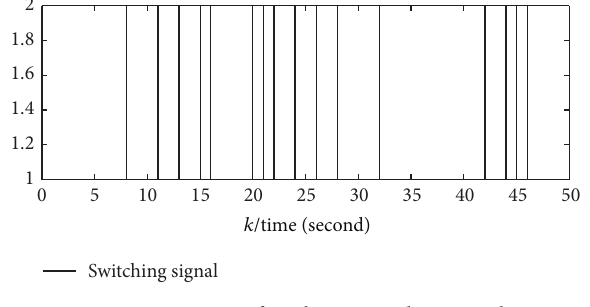
Figure 6: Curves of stochastic switching